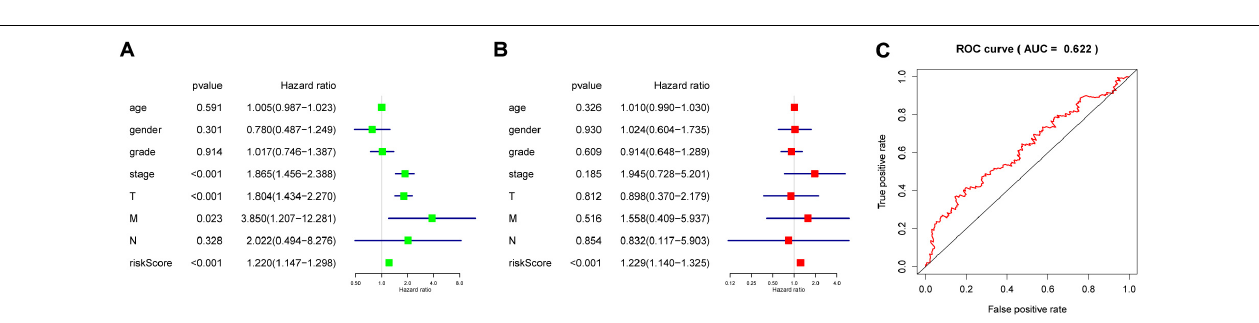
FIGURE 7 | (A) Heatmap and clinicopathological characteristics of the subgroup classified by the six-gene prognostic signature in LIHC. (B) Kaplan–Meier survival curves of LIHC subgroups defined by the six-gene signature based on the LASSO regression. Kaplan–Meier OS curves for patients with (C) stage I + II and (D) III + IV LIHC. Kaplan–Meier OS curves for patients with stage (E) T1 + T2 and (F) T3 + T4 LIHC. LIHC, liver hepatocellular carcinoma; OS, overall survival.